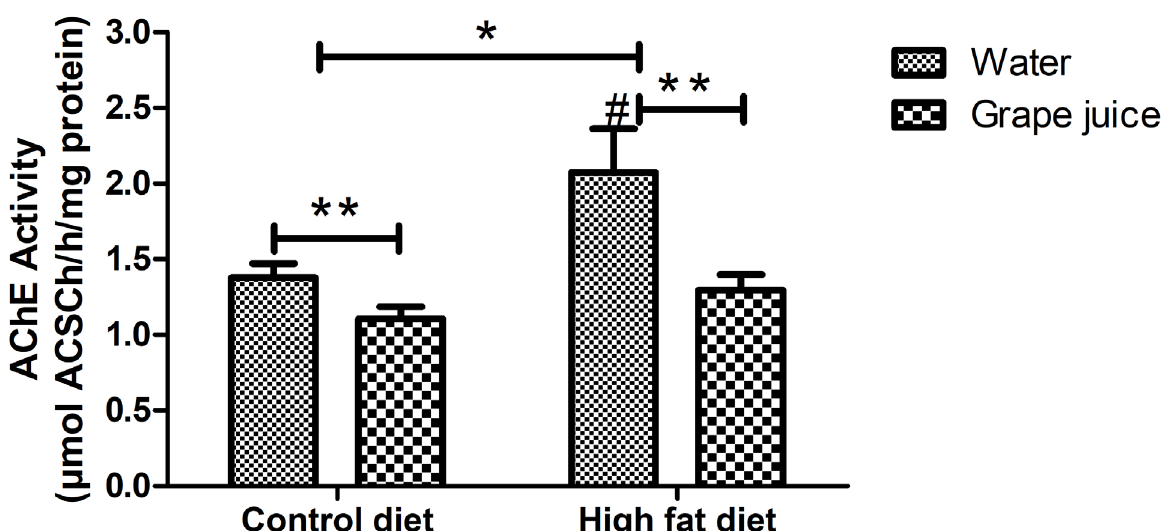
Figure 1. Acetylcholinesterase enzyme activity levels, expressed as mean ± standard error of the mean in the female pups hippocampus of Wistar rats treated with purple grape juice during the gestational period. * Difference between groups in relation to diet. ** Difference in relation to the beverage factor. # factors interaction, higher value in the group that received hyperlipidic diet and water. Statistical difference according to two-way ANOVA, followed by Tukey test, p